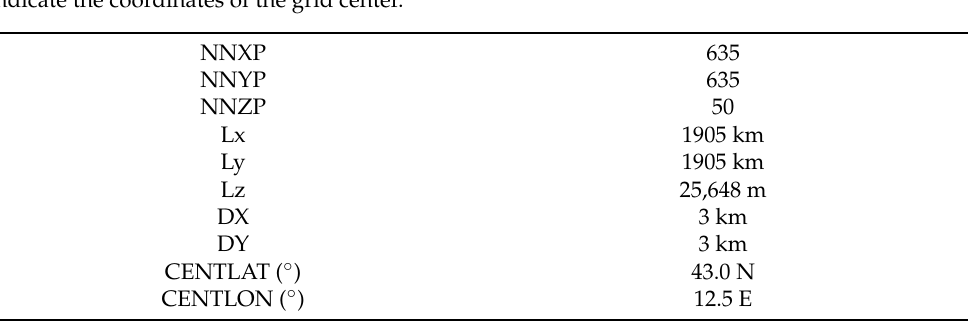
Table 2. RAMS@ISAC grid parameters. NNXP and NNYP are model grid points in both WE and SN directions, while NNZP indicates the number of vertical levels. DX and DY are the grid spatial dimensions in the WE and SN directions, respectively. Lx, Ly and Lz represent the domain extension in WE and SN directions and in the vertical direction, respectively. CENTLON and CENTLAT indicate the coordinates of the grid center.